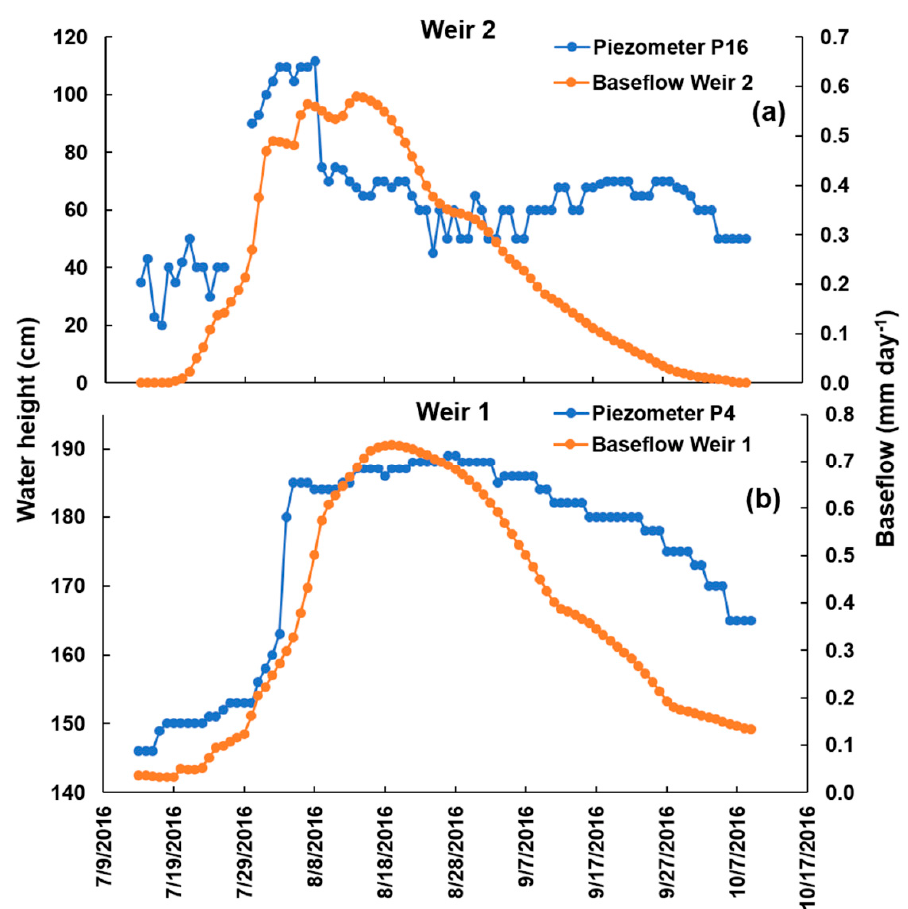
Figure 11. The relationship between ( a ) baseflow rise at weir 2 and water height at piezometer 16; and ( b ) baseflow rise at weir 1 and water height at piezometer 4.